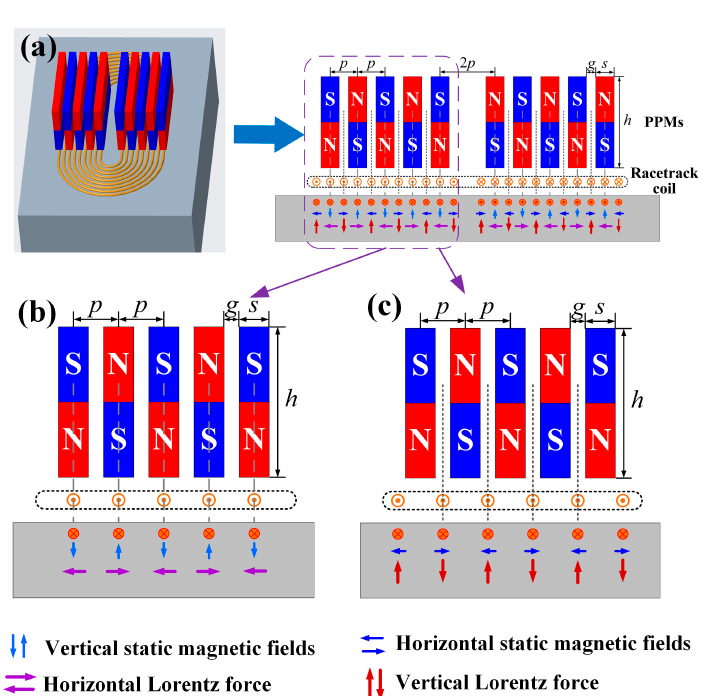
Figure 1. Schematics of the Lamb wave EMAT. ( a ) periodic permanent magnet EMAT. ( b ) WBM EMAT model, in which wires are aligned beneath the magnet units. ( c ) WBG EMAT model, in which wires are aligned beneath the gaps between magnets. p is the magnet spacing, s and h are, respectively, the width and height of the magnet units, and g is the gap between adjacent magnet